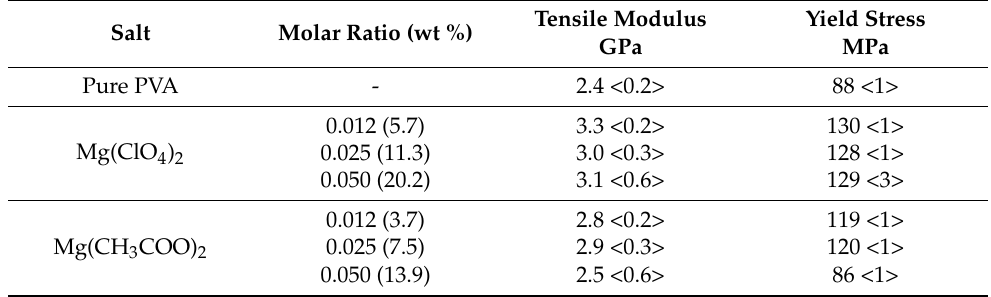
Figure 6. Stress–strain curves of films containing Mg(ClO 4 ) 2 ( left ) and Mg(CH 3 COO) 2 ( right ) at 23 °C. The numerals in the figure represent the molar ratios of the salts. Table 1. Tensile properties of the films. Table 1. Tensile properties of the films.